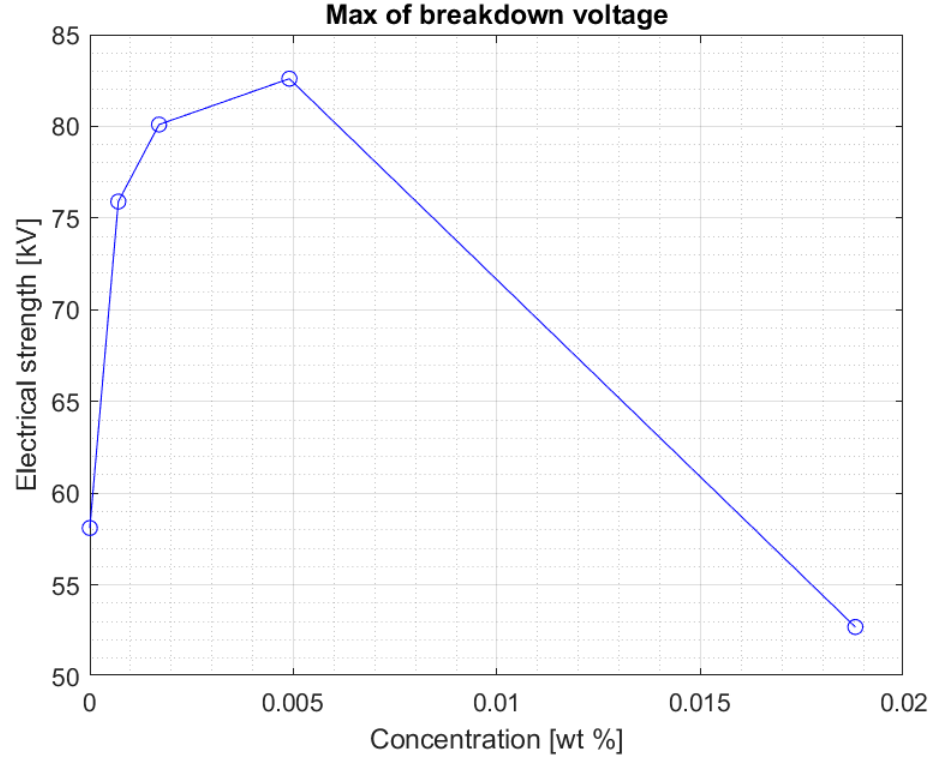
Figure 9. Maximum breakdown voltage values achieved for di ff erent nanoparticle concentration in the doped ester after ten weeks mixing.